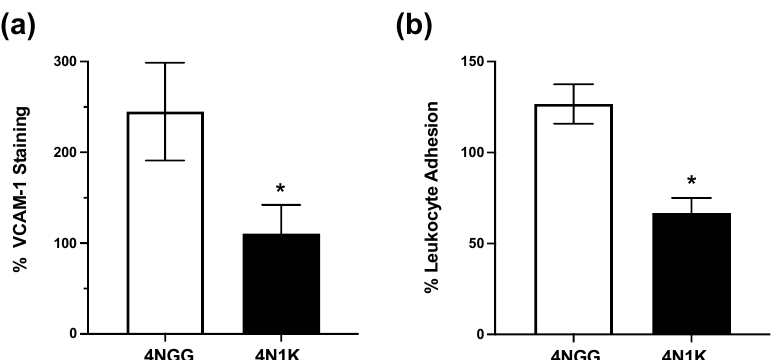
Figure 5. CD47-mediated signals in vascular endothelial cells inhibit IL-17-induced VCAM-1 ex- pression and leukocyte adhesion. Primary cultures of vascular endothelial cells from WT mice were treated overnight with IL-17 (10 ng/mL) alone or in the presence of CD47-binding 4N1K or control 4NGG peptides (10 nM). ( a ) To determine VCAM-1 expression, cells immunostained for VCAM-1 (red) (200×) were imaged and analyzed using ImageJ software, as described in Materials and Meth- ods. Nuclei were stained with DAPI (blue). Results are shown as the mean fluorescence staining relative to untreated cells ± SEM; ( b ) To determine leukocyte adhesion, treated cells were washed gently and overlaid with CFSE-labeled leukocytes, as described in Materials and Methods, and after washing away non-adherent cells, fluorescence intensity of adherent cells was measured using a fluorescence microplate reader. Data are presented as the mean fluorescence intensity of adherent cells relative to untreated cells ± SEM. n = 3 – 4 each treatment. * p < 0.05 .